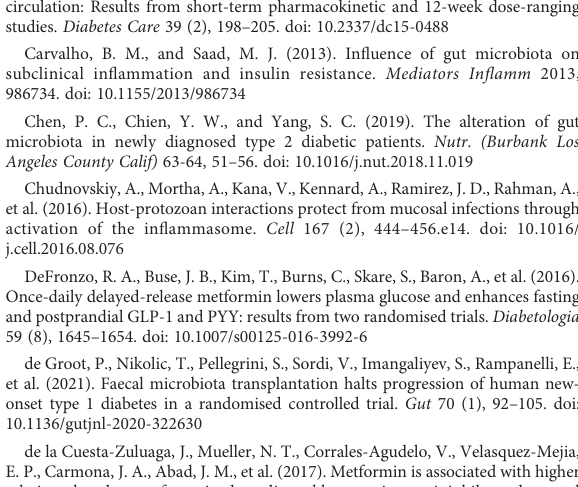
SUPPLEMENTARY TABLE 1 Basic information and clinical data of